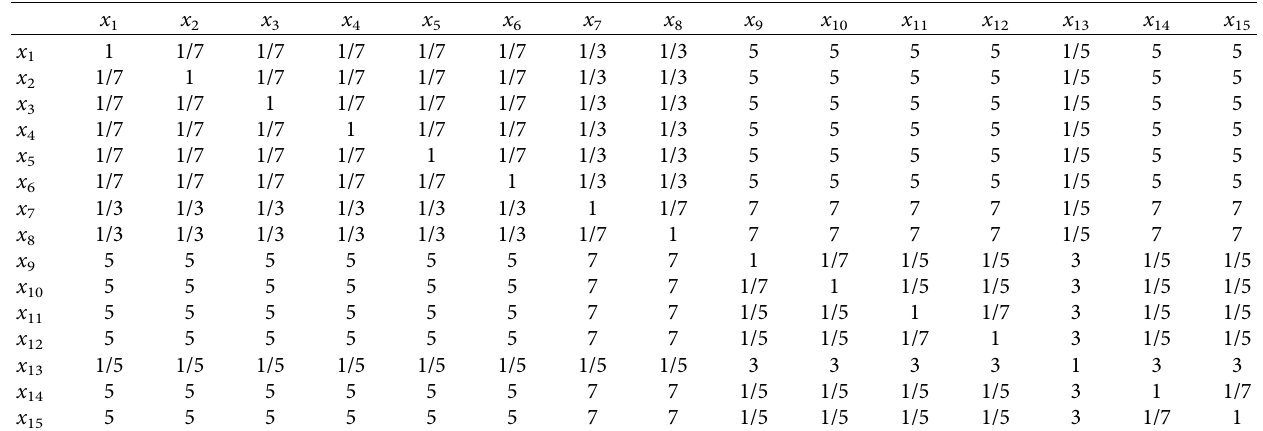
Figure 3: The flowchart of TOPSIS method for dynamic attributes. Table 2: The location-related matrix B .